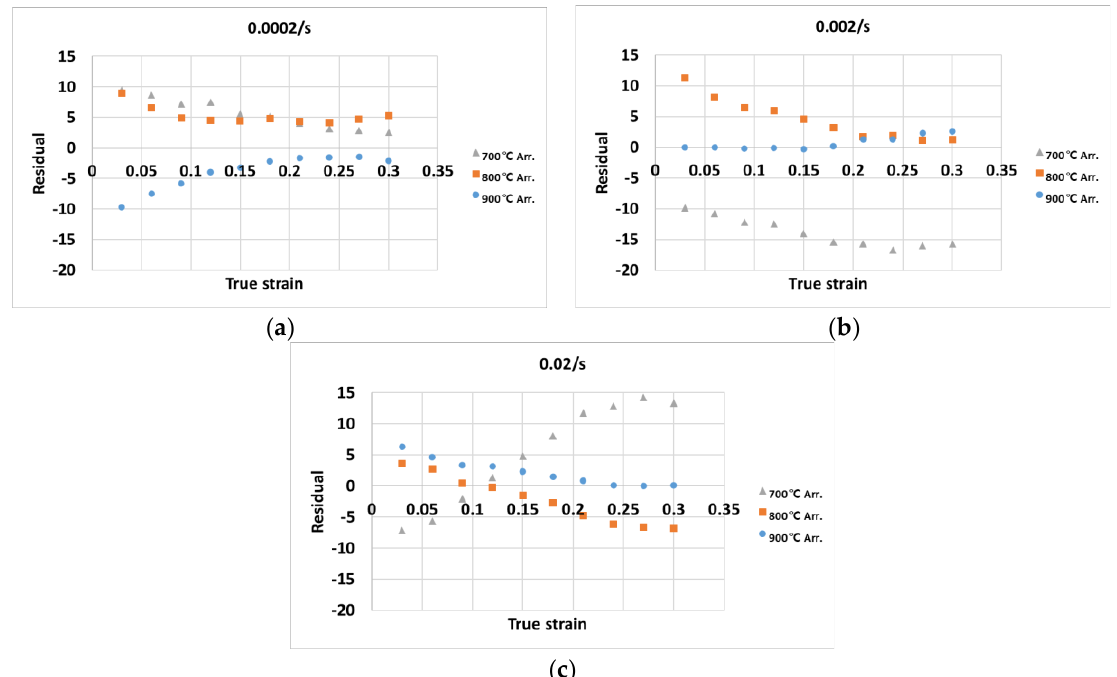
Figure 6. Residual plots of the calculated stress by the Arrhenius-type equation at ( a ) the strain rate 0.0002/s, ( b ) strain rate 0.002/s, ( c ) strain rate 0.02/s.